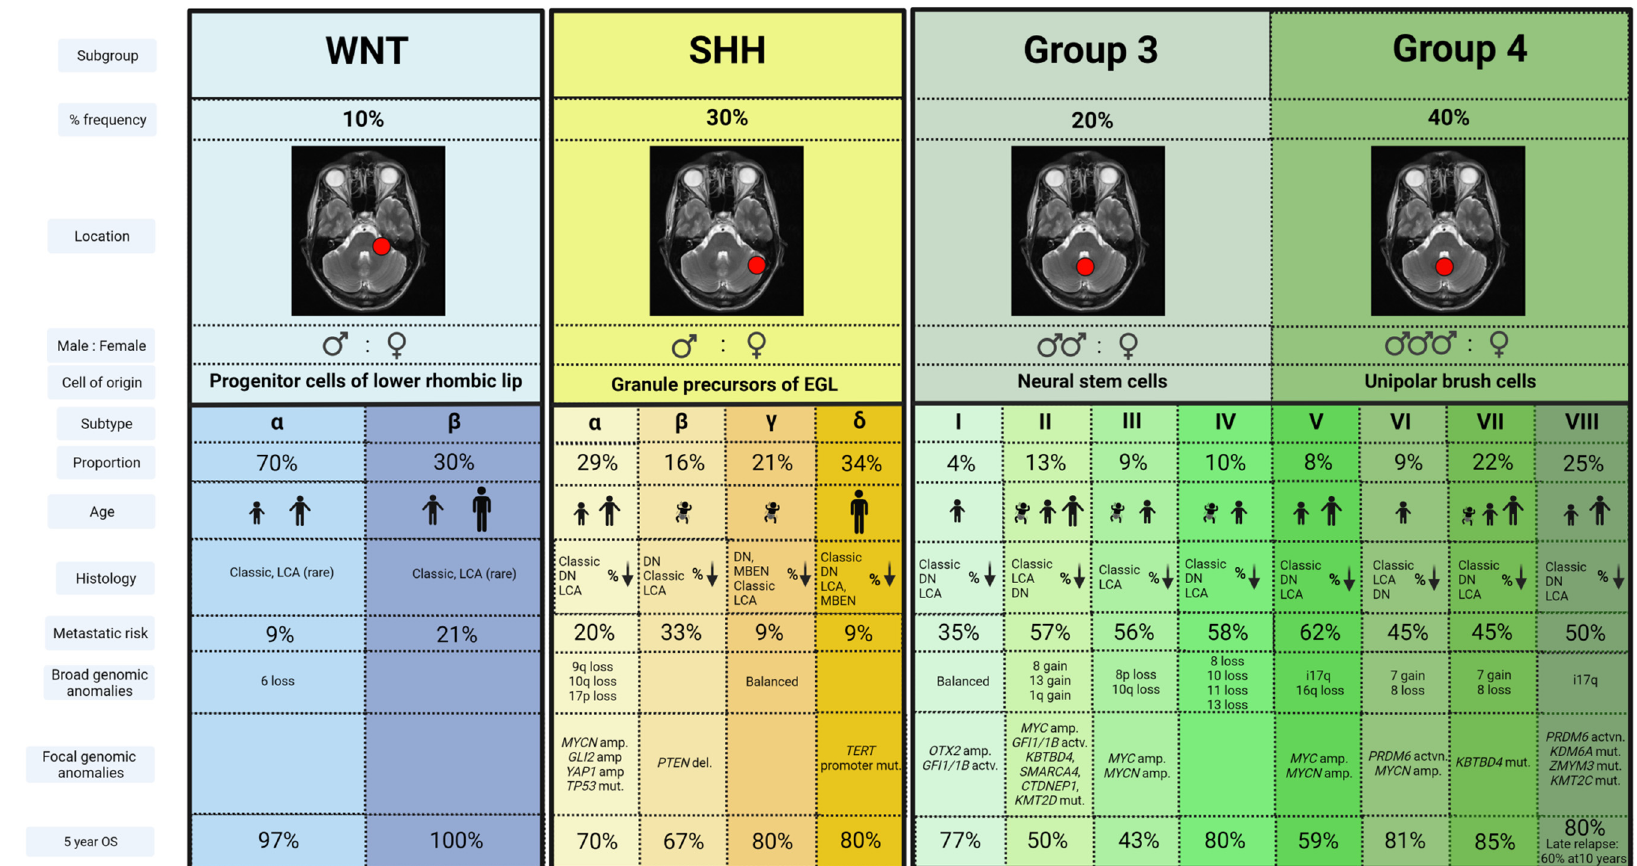
Figure 1. Molecular subgroups and in-group subtypes of medulloblastoma; the four globally recognized molecular subgroups of medulloblastoma (WNT, SHH, Group 3 and Group 4) are shown, together with the current subtypes within WNT and SHH subgroups, as per [13], and Groups 3 and 4, in accordance with [14,15]. Two WNT-activated subtypes are reported, alongside 4 SHH subtypes. Groups 3 and 4 are likely now best considered as a spectrum of 8 different subtypes, each with biological and clinical characteristics. Age-related cartoons depict infant, young child (2–5 years), child (5–12 years), adolescent and older (12+ years). Key: OS = overall survival, DN = desmoplastic/nodular histology, LCA = large cell anaplastic histology, MBEN = medulloblastoma with extensive nodularity, amp. = amplification, mut. = mutation, del. = deletion, and actvn. = activation.